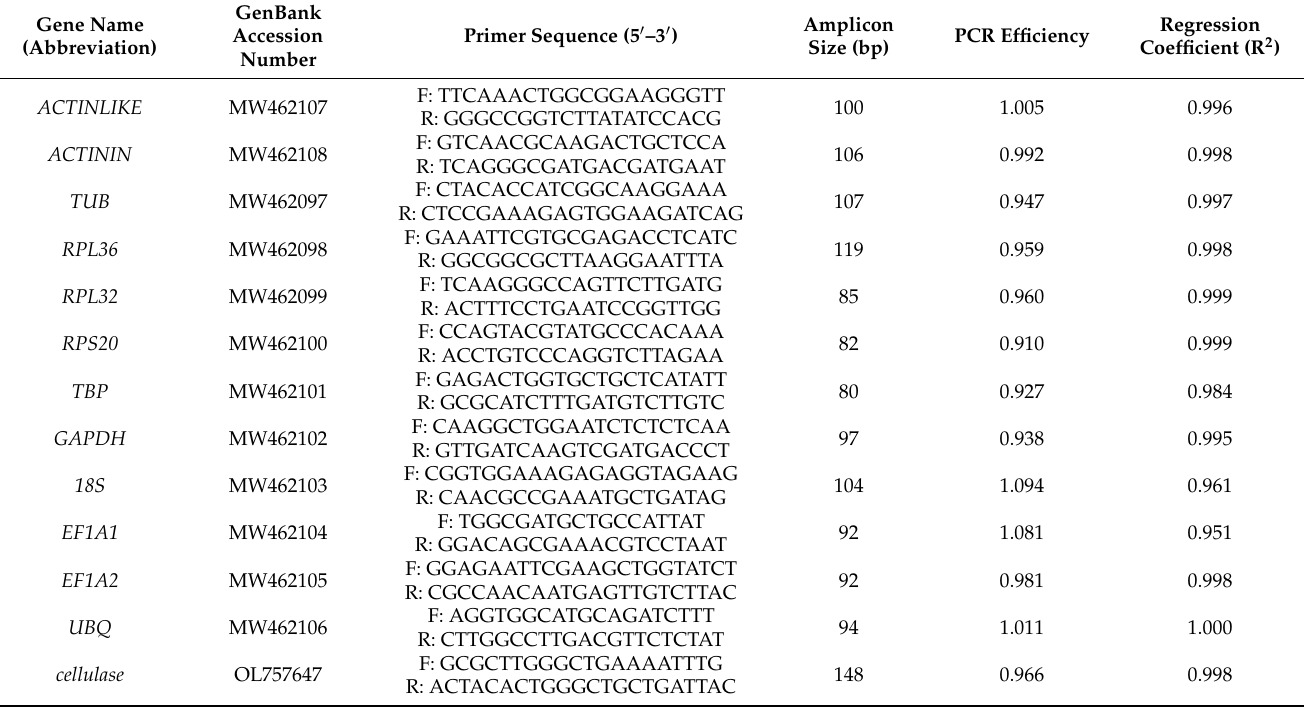
Table 2. Primers of G. cantor used for qRT-PCR